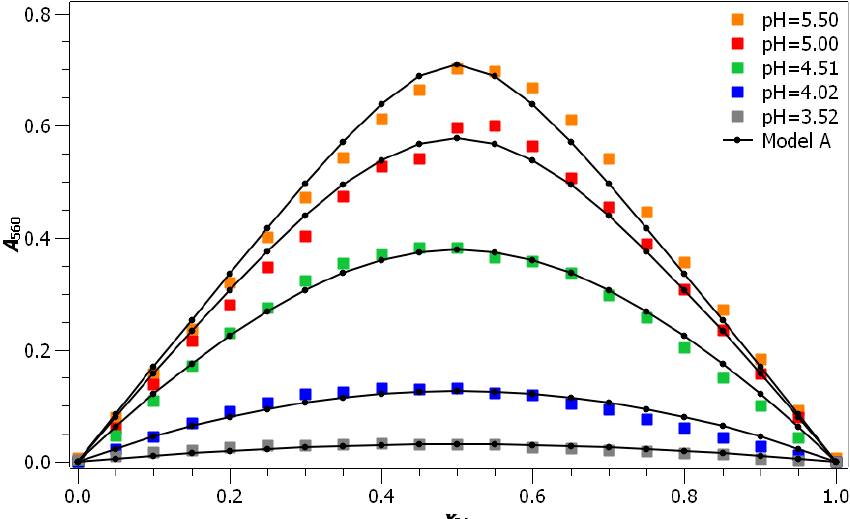
Figure 3. Model function A in comparison to experimental results for sets with c = 5 · 10 − 4 mol · L − 1 ( R 2 =